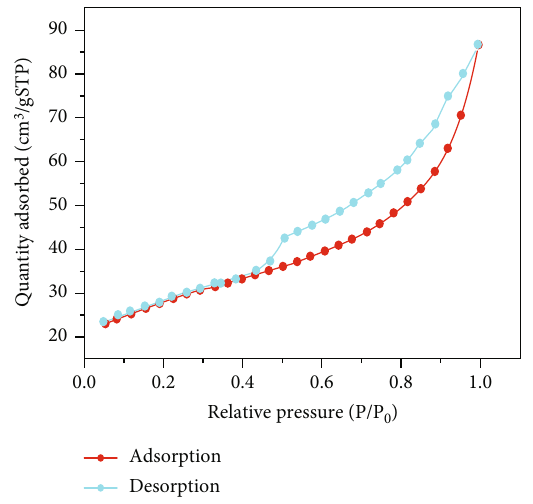
Figure 4: The adsorption/desorption isotherms on samples of attapulgite.